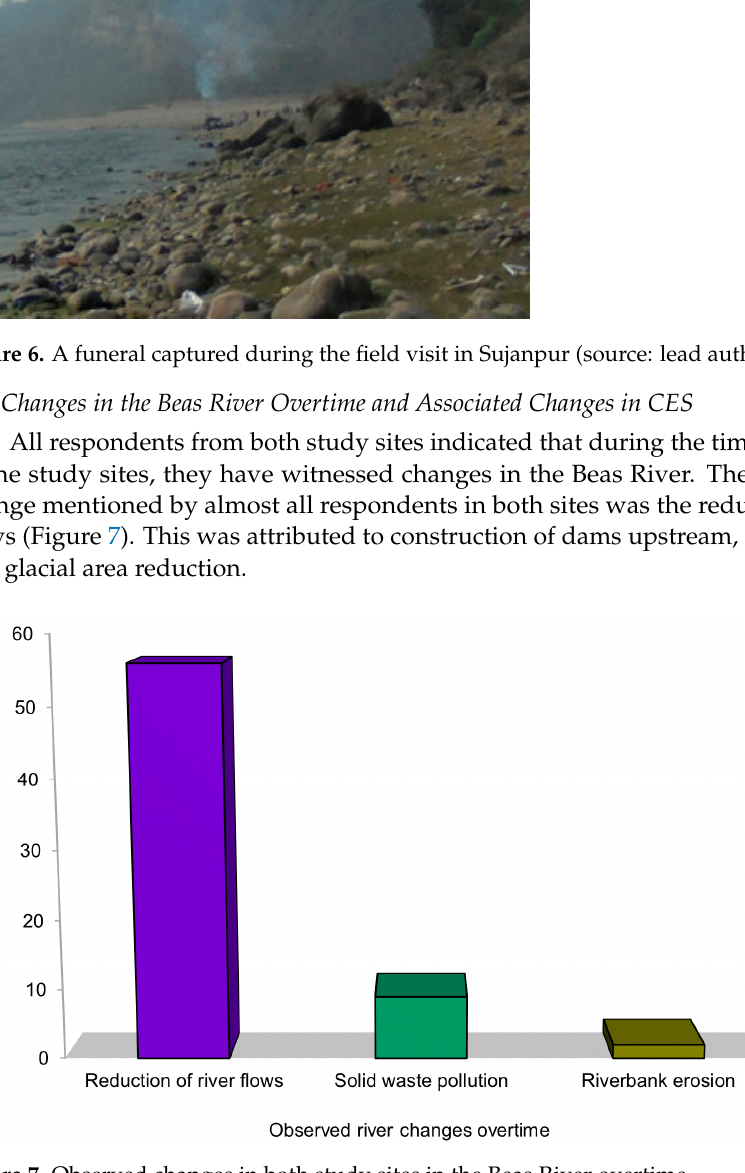
Figure 5. Some of the materials immersed in the Beas River during cultural rituals/ceremonies. ( a ) floating red material remnants and ( b ) statues/idols in the riverbed (source: lead author, 2017).